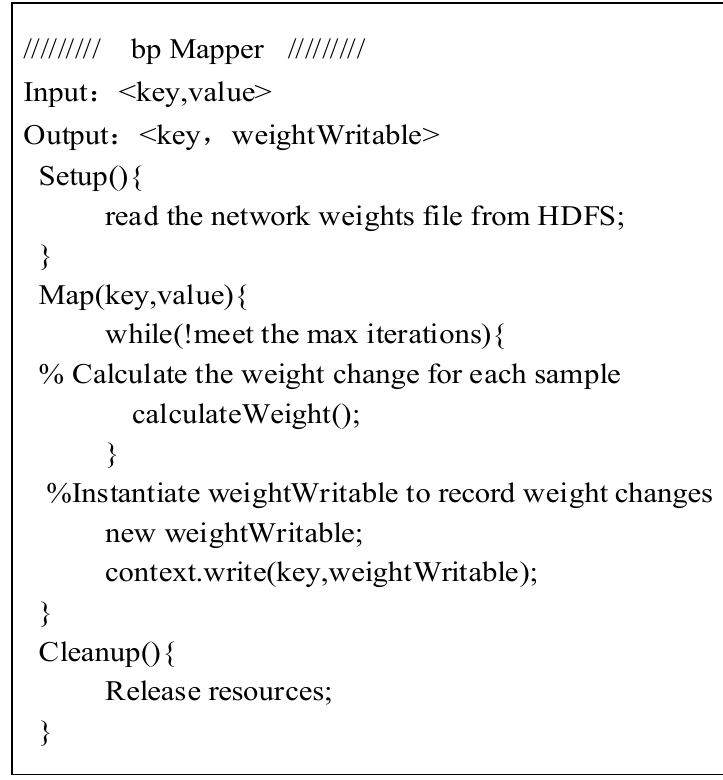
Figure 10. The pseudo code of Map stage.